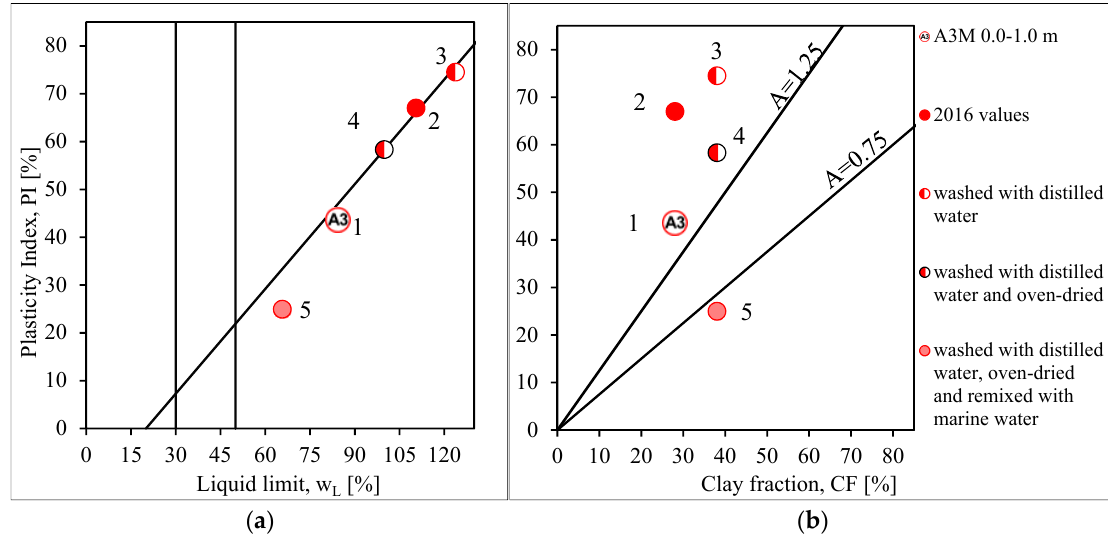
Figure 11. Results of the washing experiments on the Atterberg limits ( a ) and on the activity index ( b ) of the shallow sample A3-M.